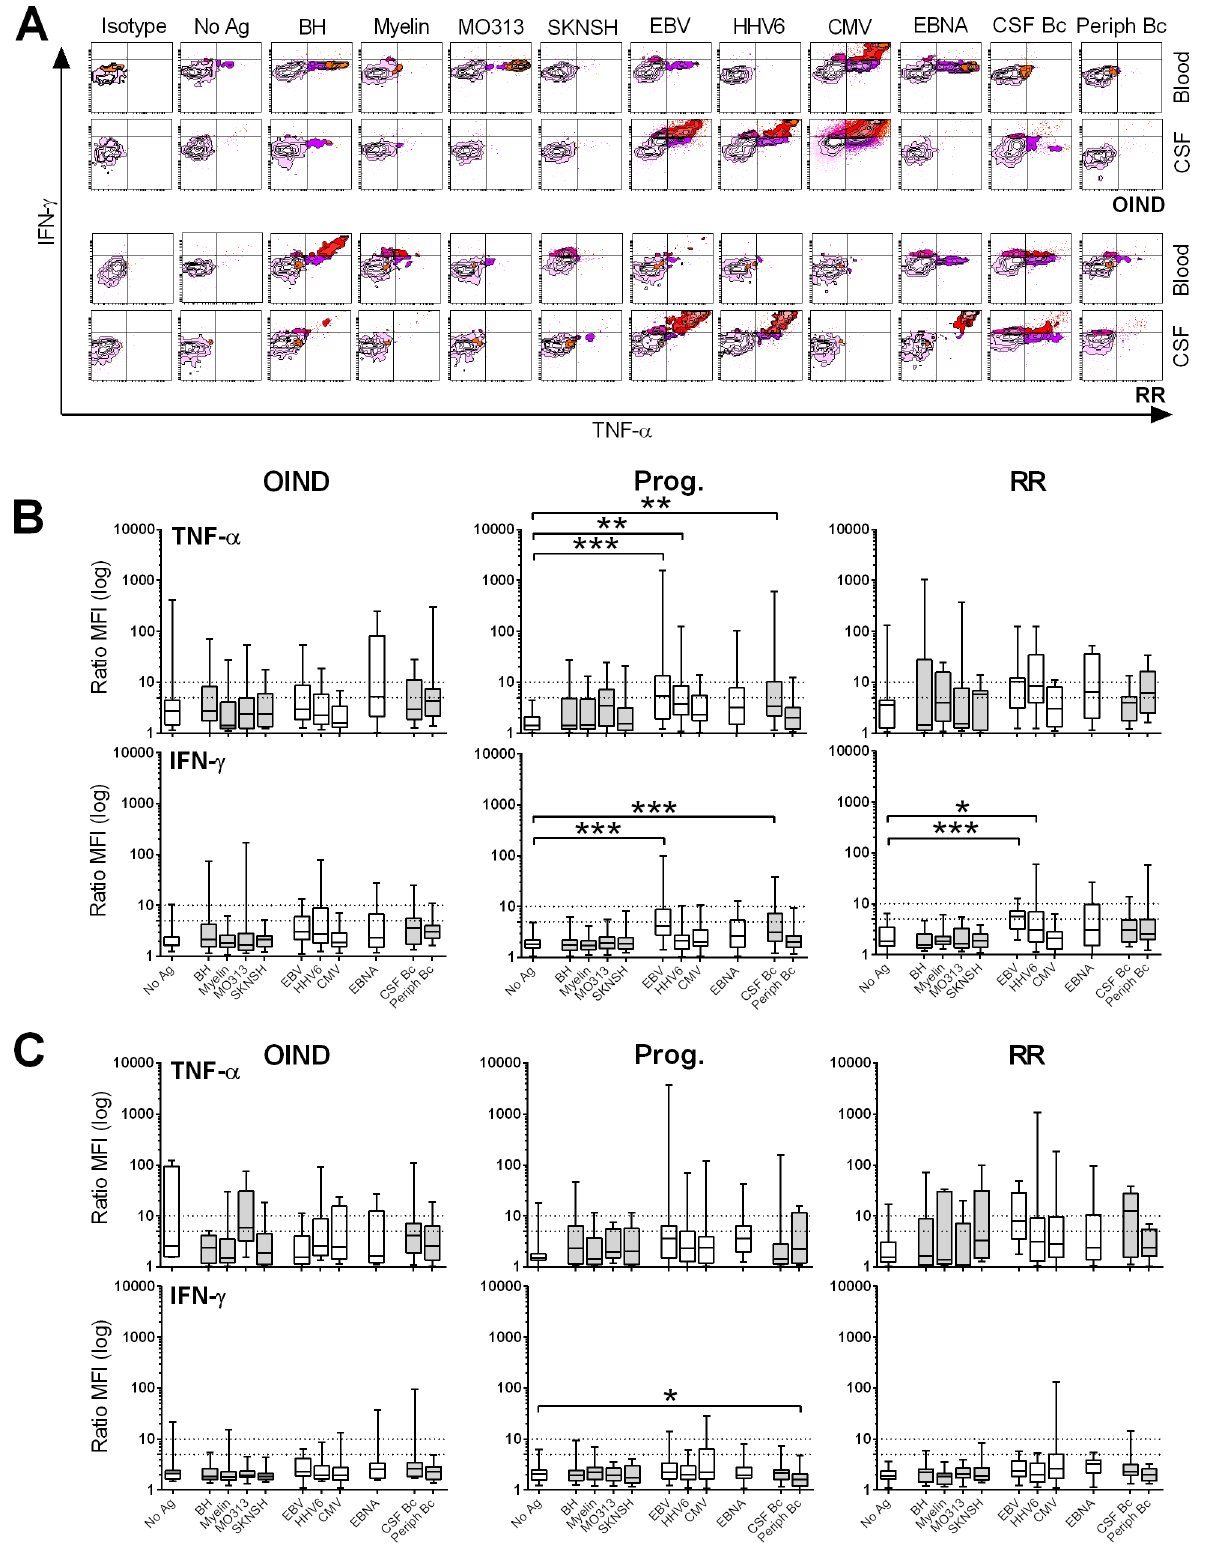
Figure 5. Differential phenotypes of peripheral and intrathecal CD4 + T cells in response to foreign Ag’s. ( A ) FACS plots illustrate intracellular TNF- a and IFN- c secretion by peripheral (Blood) and intrathecal (CSF) CD4 + T cells in response to all candidate Ag’s. Gating is based on the isotype controls (far left plots). Upper panels correspond to one representative OIND patient; lower panels correspond to one representative un- treated RRMS patient. MFI ratios of intrathecal to peripheral CD4 + ( B ) and CD8 + T cells ( C ) were calculated for TNF- a (upper panel) and IFN- c (lower